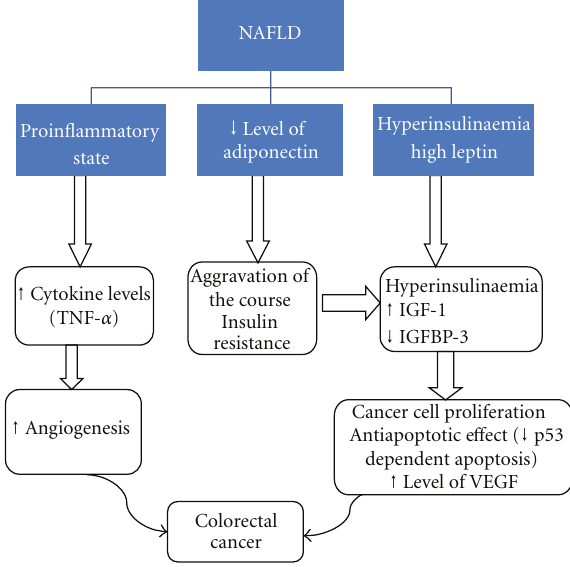
Figure 2: A proposed mechanism of how metabolic syndrome and NAFLD influence carcinogenesis in colorectal cancer. MS: metabolic syndrome; ILGF-1: insulin-like growth factor-1; IGFBP- 3: insulin growth factor binding protein-3; VEGF: vascular endothe- lial growth factor; TNF: tumour necrosis